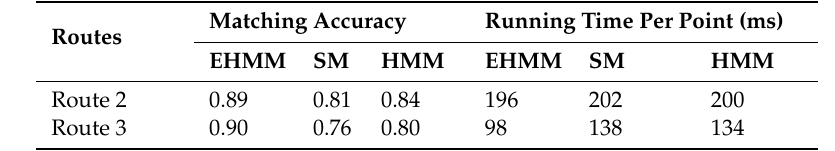
Table 1. Evaluation of matching performance among MM models based on dataset 2.